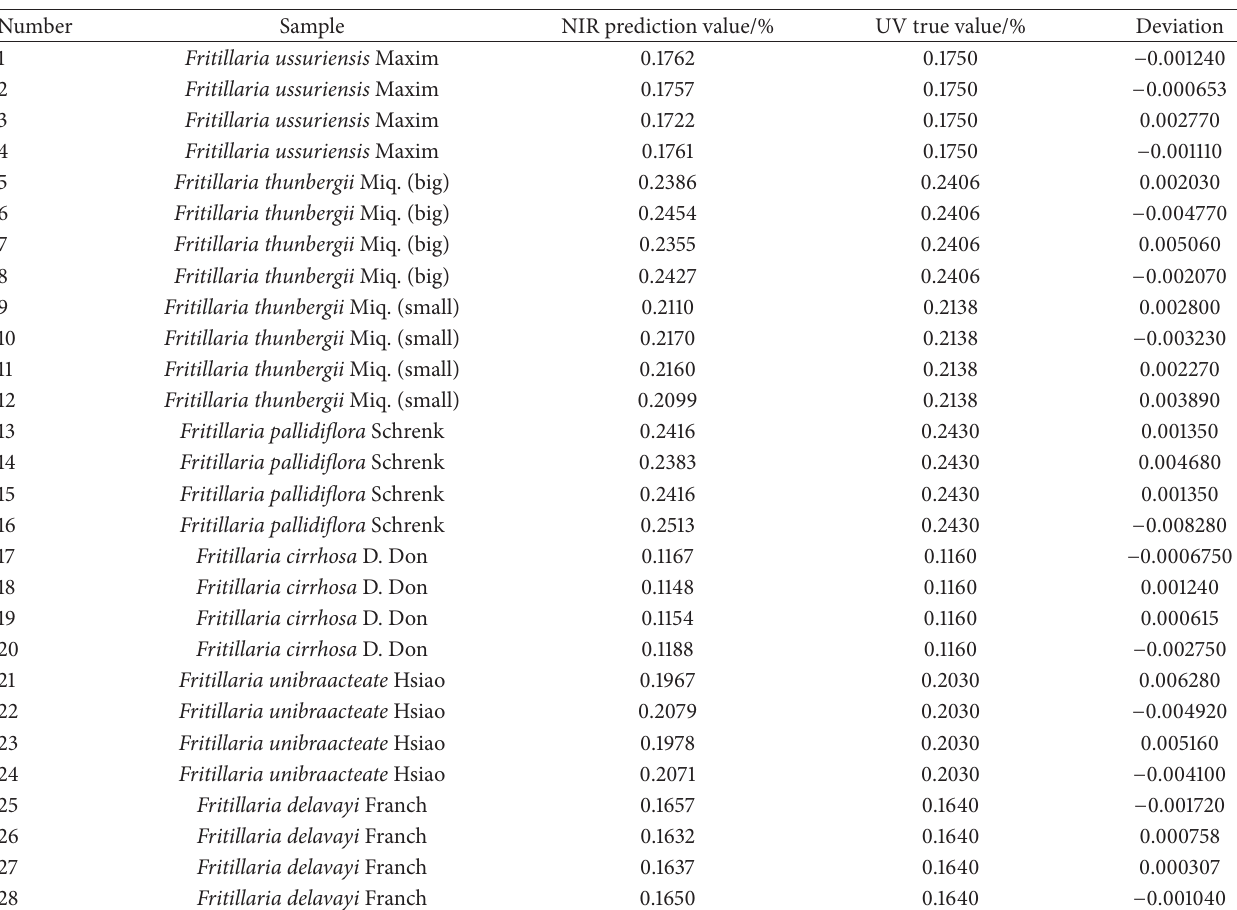
Table 4: Quantitative predictions for the samples in prediction set by PLS